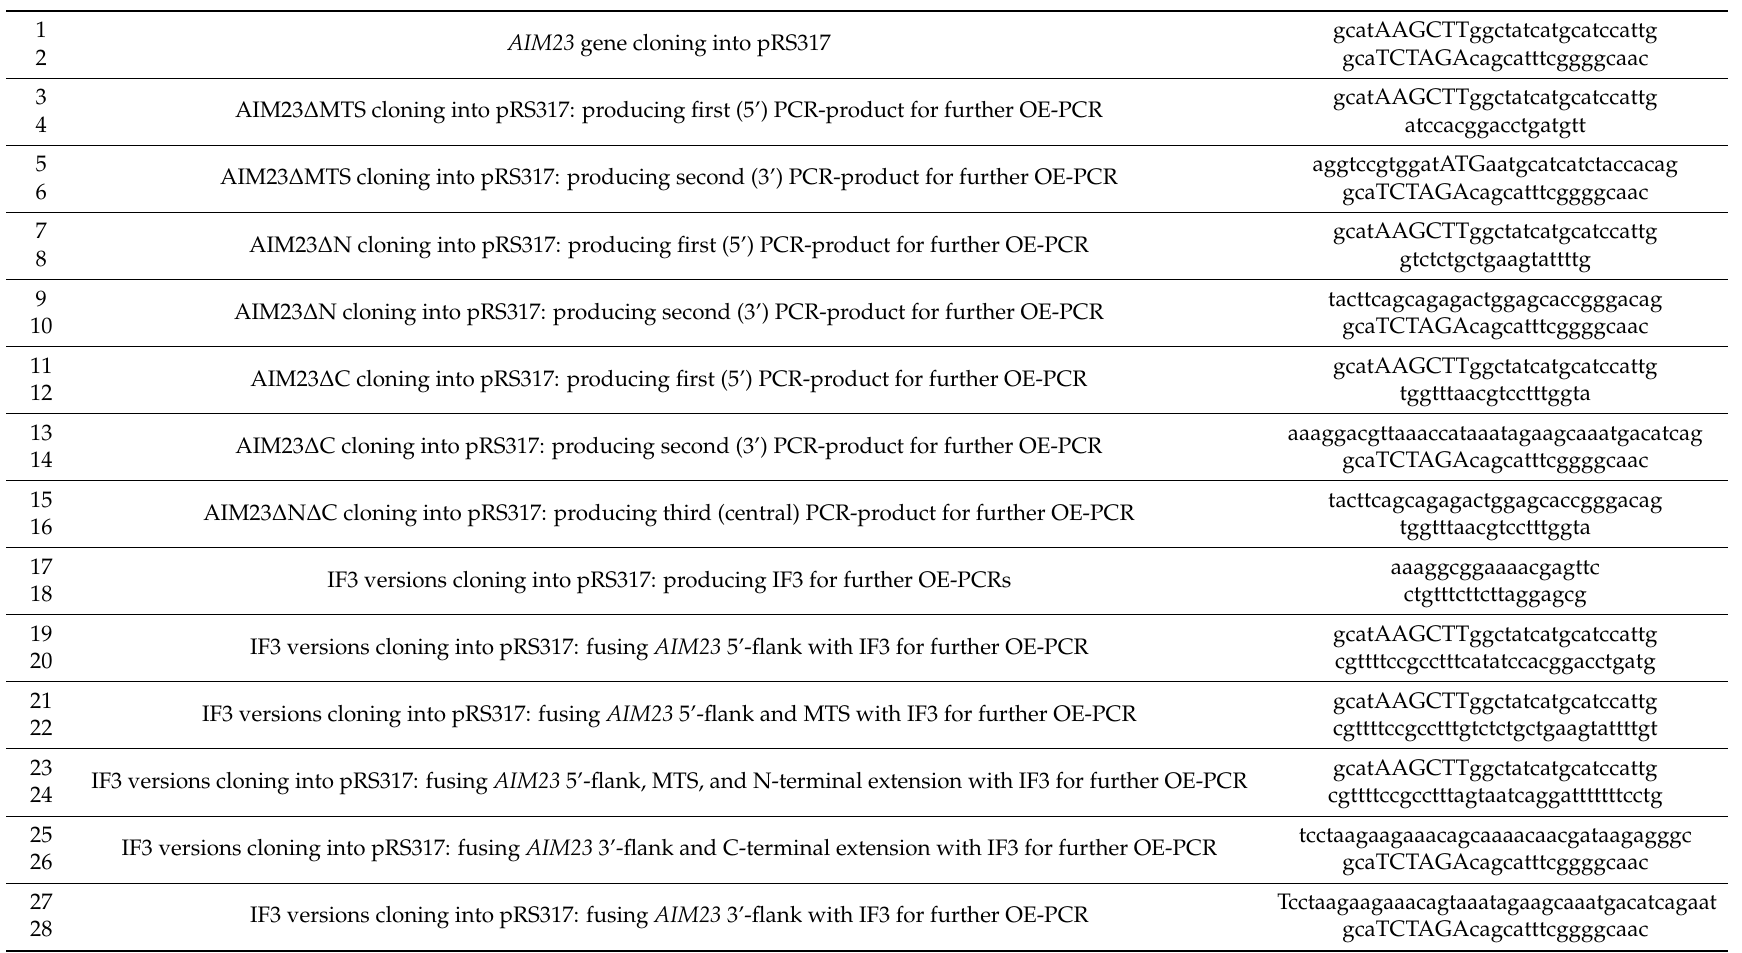
Table 3. Oligonucleotides used in the